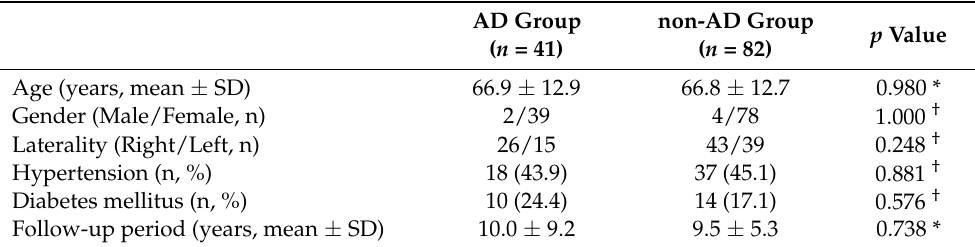
Table 1. Demographics of patients.